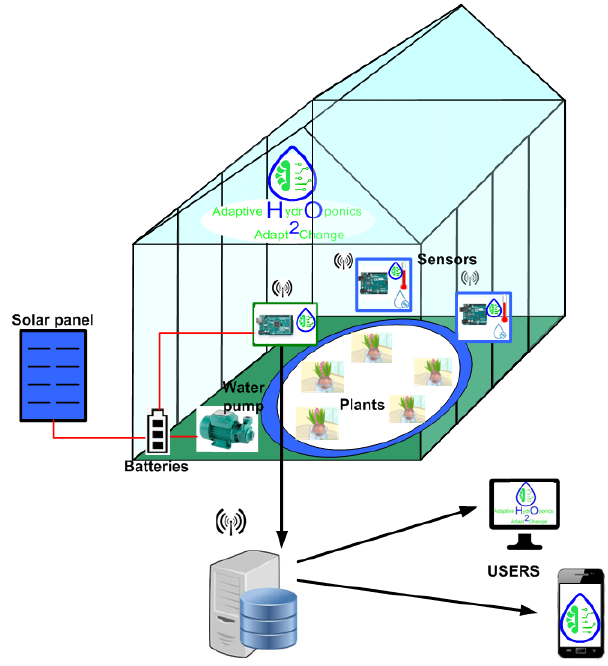
Figure 1. iPONICS system concept.